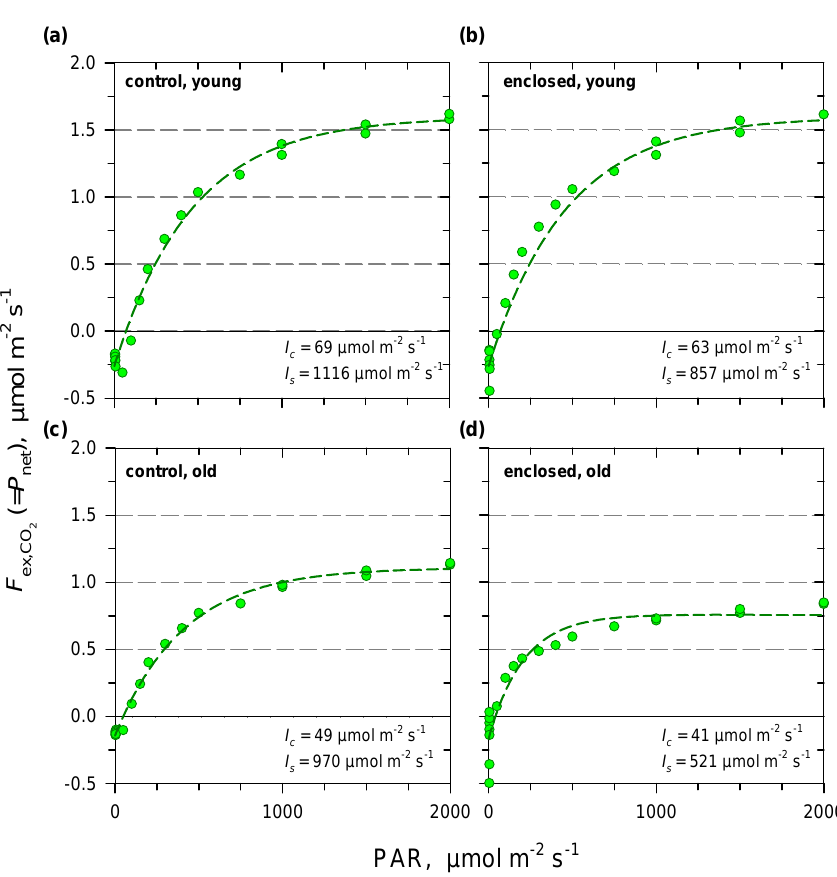
Figure 1. Photosynthetic light response curves at ambient CO 2 concentration (370 - 390 ppm) 2 Fig. 1. Photosynthetic light response curves at ambient CO 2 concentration (370–390ppm) of control and enclosed spruce needles. (a) Young control needles, (b) young enclosed needles, (c) older control needles, (d) older enclosed of control and enclosed spruce needles. (a) young control needles, (b) young enclosed 3 needles, (c) older control needles, (d) older enclosed needles. 4